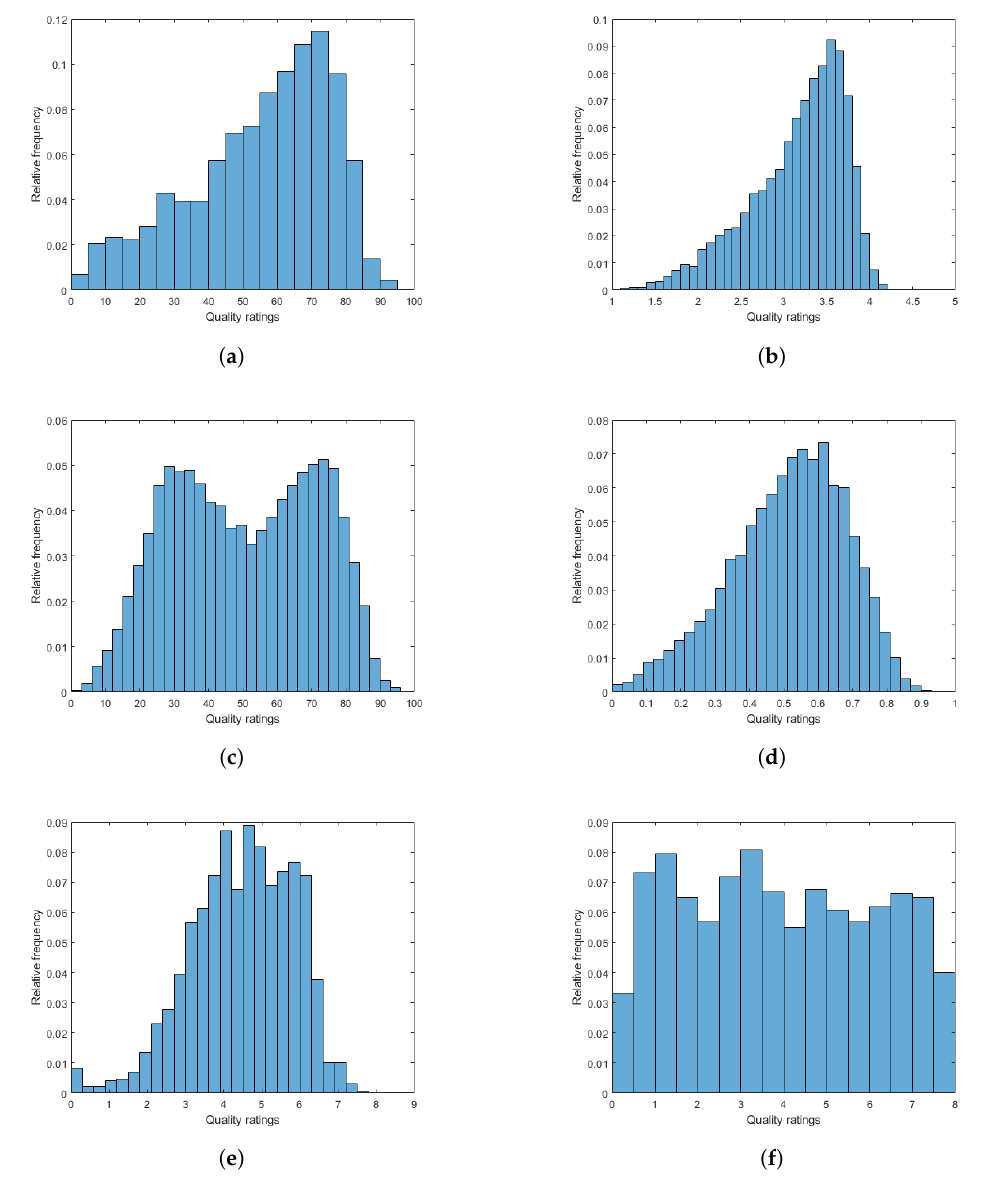
Figure 3. The empirical distributions of quality ratings in the considered IQA benchmark